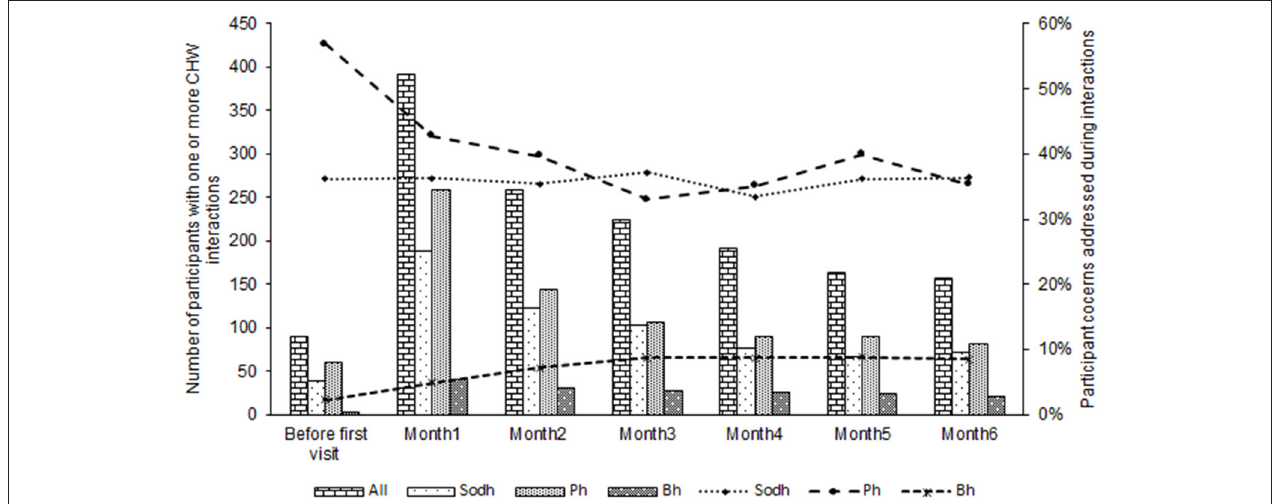
FIGURE 2 | Number of participants with a CHW interaction and participant issues addressed during interactions over time. NB: Bars represent number participants with an interaction and issues addressed. Lines represent proportion of all interactions that addressed Sdoh, Bh, and Ph issues. Sdoh, social determinants of